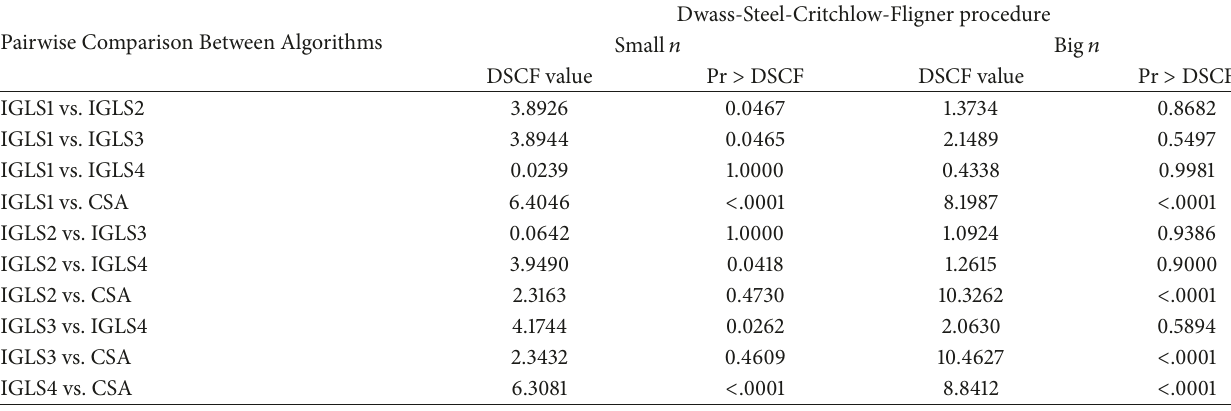
Table 5: Critchlow-Fligner procedure for differences among algorithms for small number of jobs. Pairwise Comparison Between